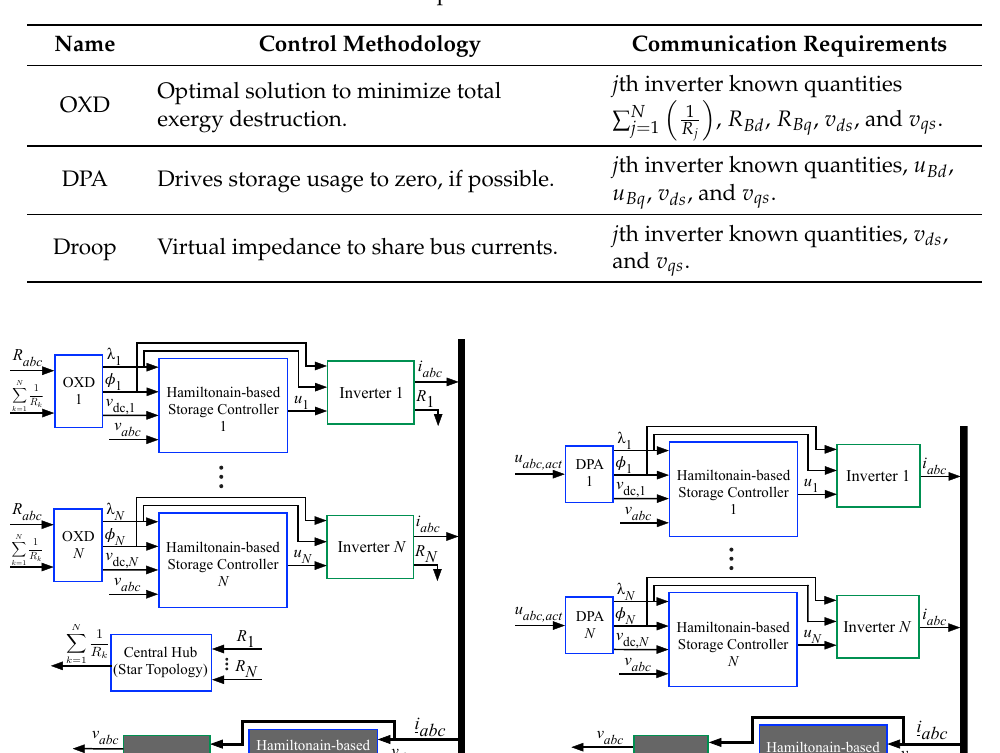
Table 1. Comparison of control methods.